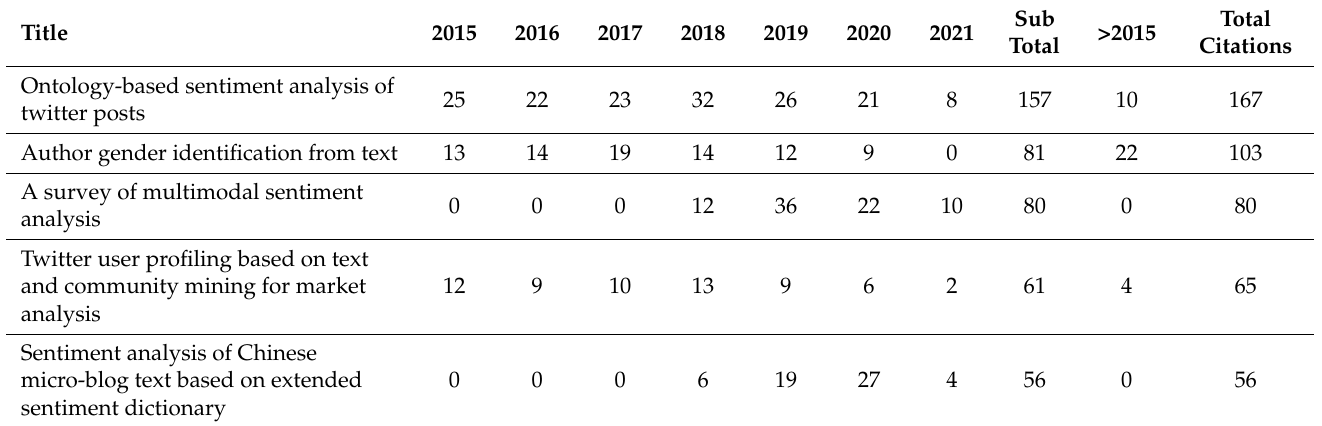
Table 17. A citation analysis of the top five publications on Web of Science.